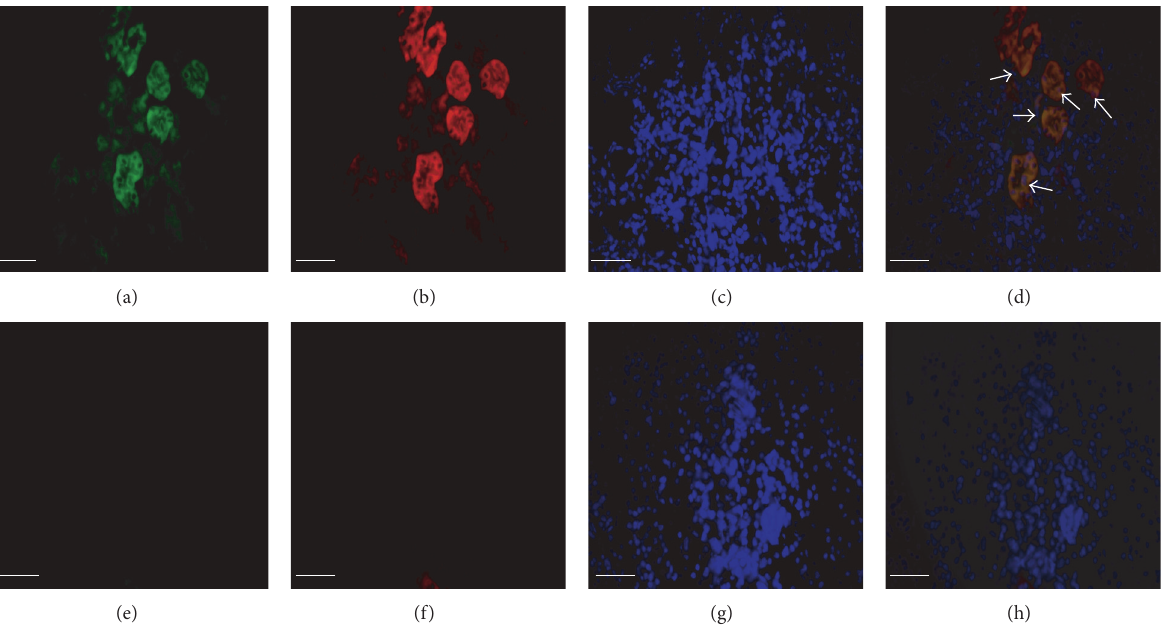
Figure 2: Endogenous coexpression of CD24 and 𝛽 -catenin/TCF reporter transgene following glycerol-induced renal injury in adult mice. (a–d) Kidney sections showing endogenous tubular cells of glycerol-treated mice: (a) immunostaining for reporter 𝛽 -galactosidase (green); (b) immunostaining for CD24 (red); (c) nuclear staining with DAPI; (d) merged images showing coexpression of 𝛽 -galactosidase and CD24 in tubular cells (white arrows). (e–h) Kidney sections showing endogenous tubular cells in control (PBS injected) mice: (e) 𝛽 -galactosidase reporter (green); (f) CD24 (red); (g) DAPI; (h) merge. Scale bars: 50 𝜇 m.